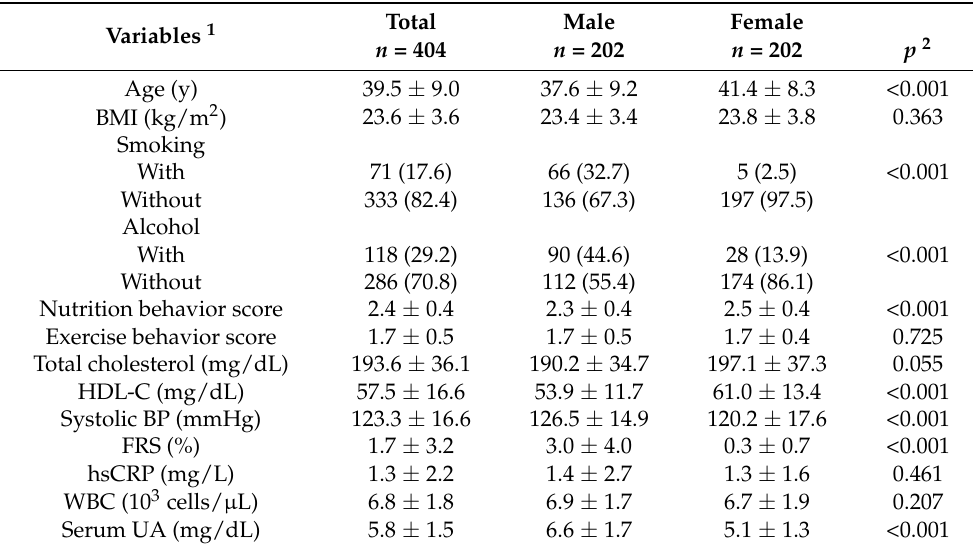
Table 1. Descriptive statistics of the participants by gender.